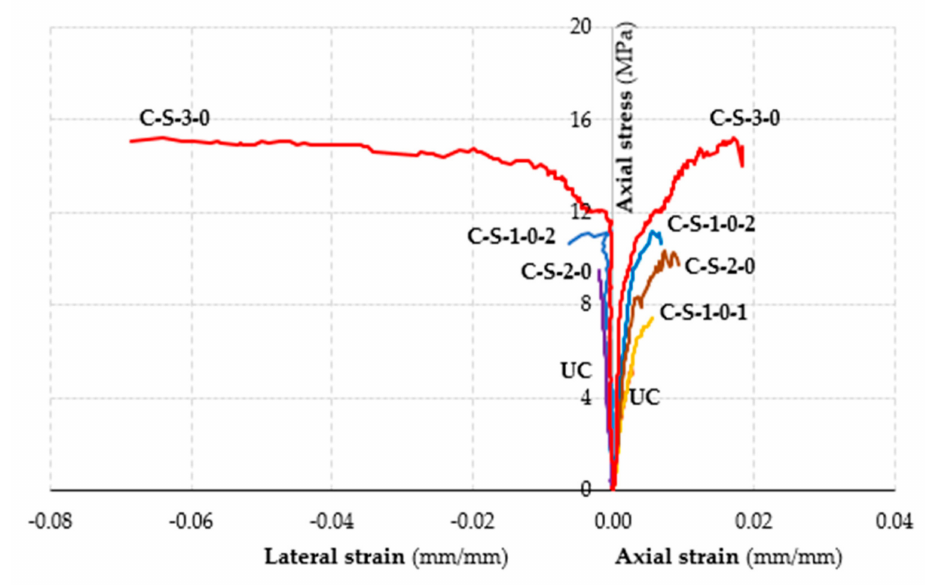
Figure 16. Axial stress -strain curves for SRG confined